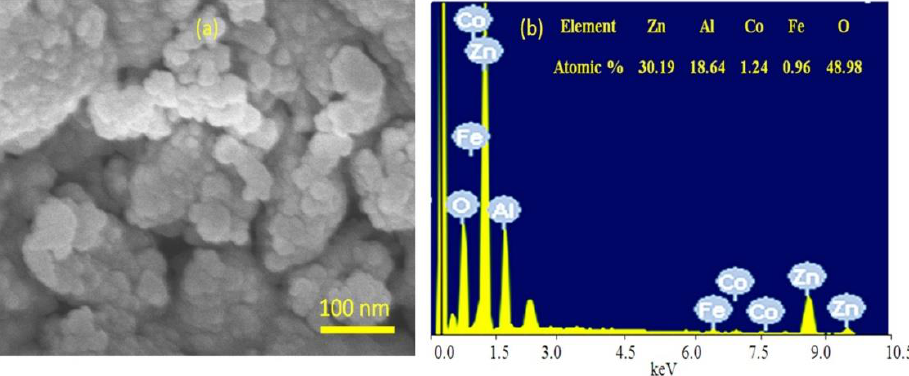
Figure 9. Images and spectrum of NHZ-1-500: ( a ) SEM and ( b ) EDX.